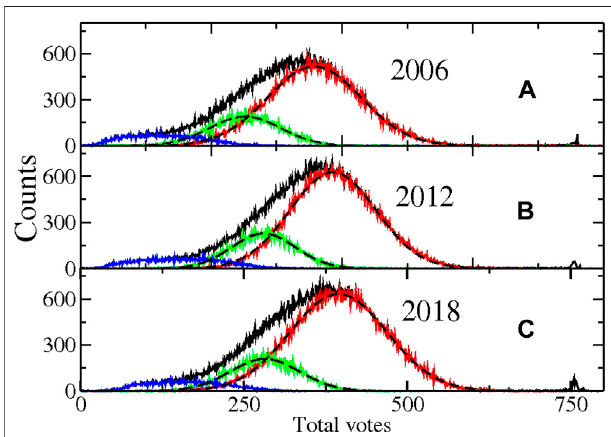
FIGURE 3 | Distribution of total votes for the presidential turnout of 2006 (A) ,2012 (B) ,and2018 (C) normalizedtothetotalnumberofvalidvotes in each process. In black line, in all the panels, the distribution corresponds to the whole election. In red, the corresponding distribution is plotted if we consider votes that come from polling stations with a Nominal List between 501 and 750, named ( I ) in Figure 2 ; in green, those from ( II ) ; and in blue, those coming from stations with a Nominal List number smaller than 375. In the broken black line appears a Gaussian fi tting for distributions in zones ( I ) and ( II )